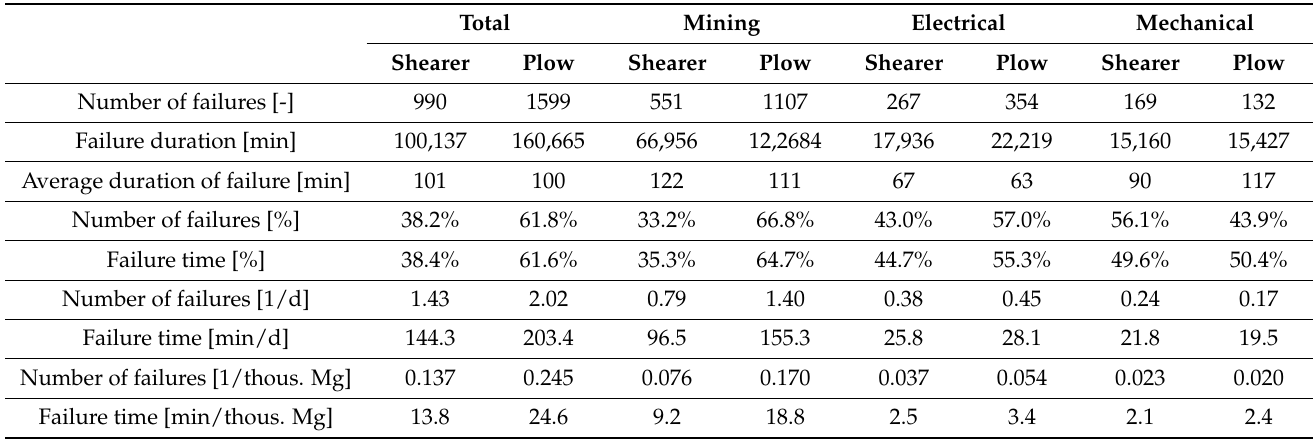
Table 2. Failure rates of shearer and plow